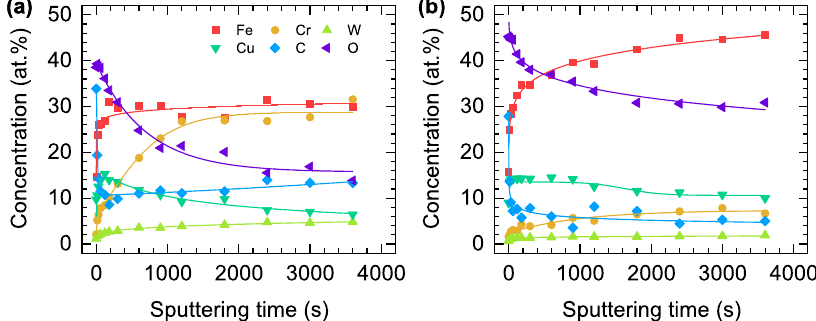
Fig. 9 Depth-wise elemental distributions of the corroded surfaces. Atomic fractions of Fe, Cr, W, Cu, C, and O elements in the 16Cr steel samples quenched from a 800 °C and b 1100 °C plotted as functions of the depth from the outermost surface after immersion in the 0.5 M H 2 SO 4 solution for 7